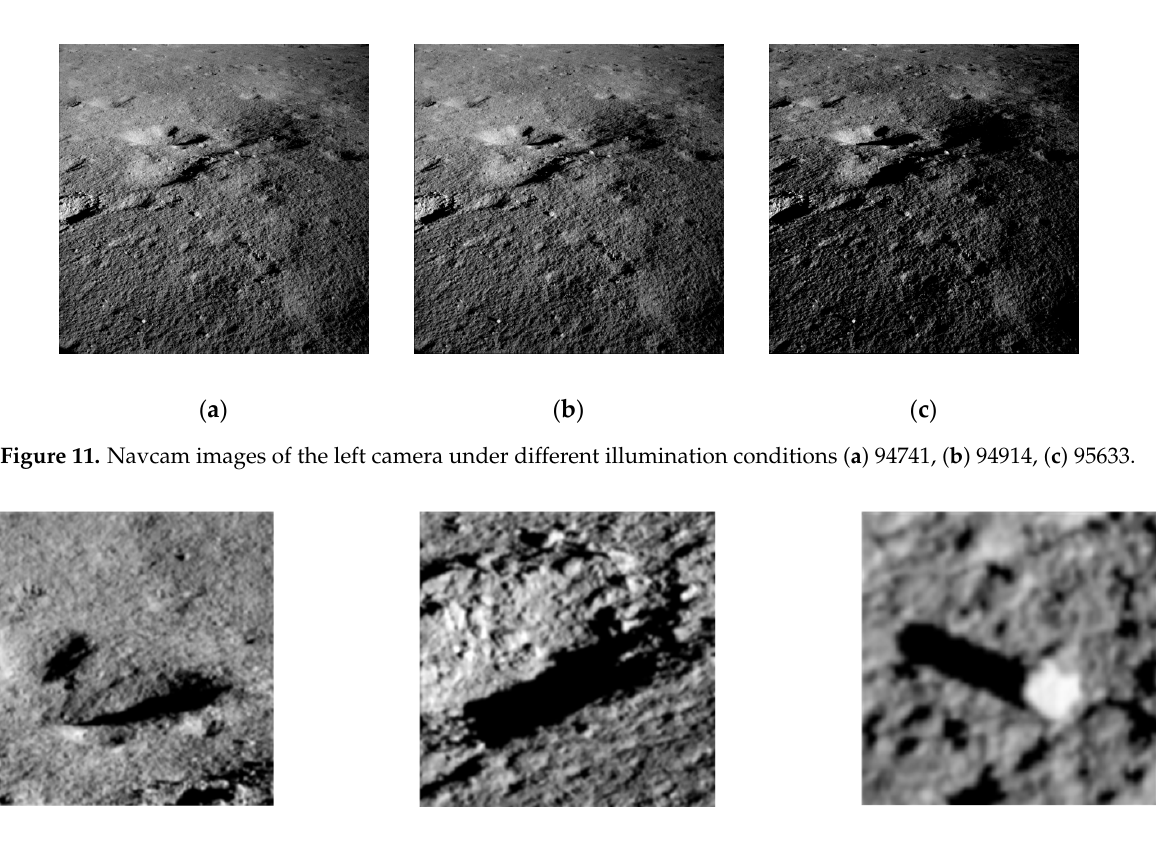
Table 3. Geometric parameters of Chang’e-4 Navcam stereo cameras.